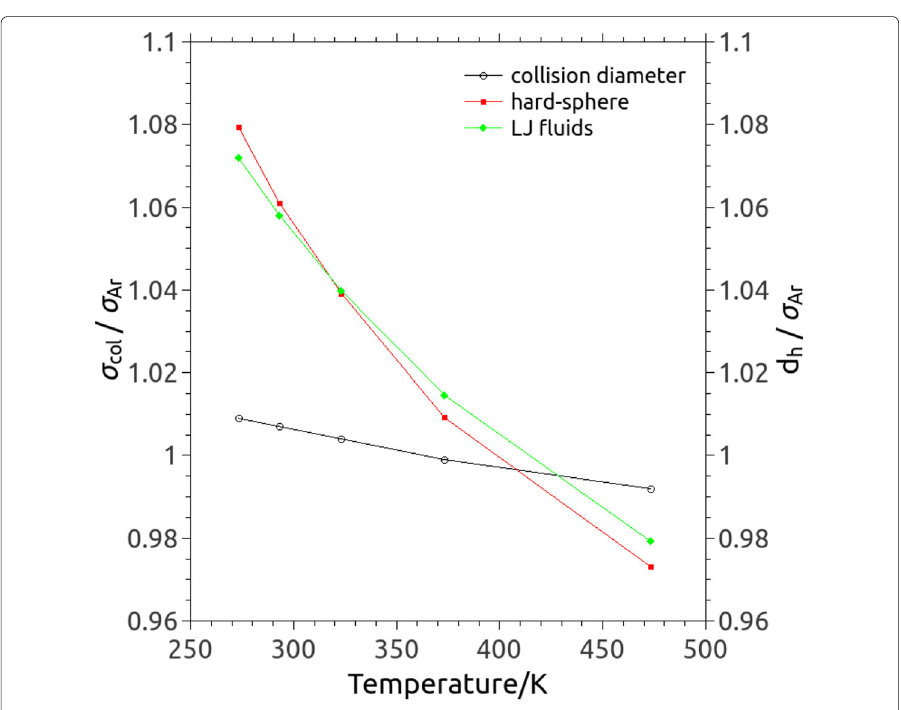
Fig. 2 Collision diameter σ col (open circles) and molecular diameter for a hard-sphere gas d h (filled red squares) vary as a function of the gas temperature, and they are normalised by the molecular diameter in MD = 3.405 × 10 − 10 m. By using Eq. (6) the prediction based on the viscosity of Lennard-Jones (LJ) fluids σ Ar (filled green diamonds) [36, 37] is also included for comparison. It can be seen that quasi-linear (i.e. MD simulations) or roughly linear (i.e. the hard-sphere gas) relationship exists in explored gas